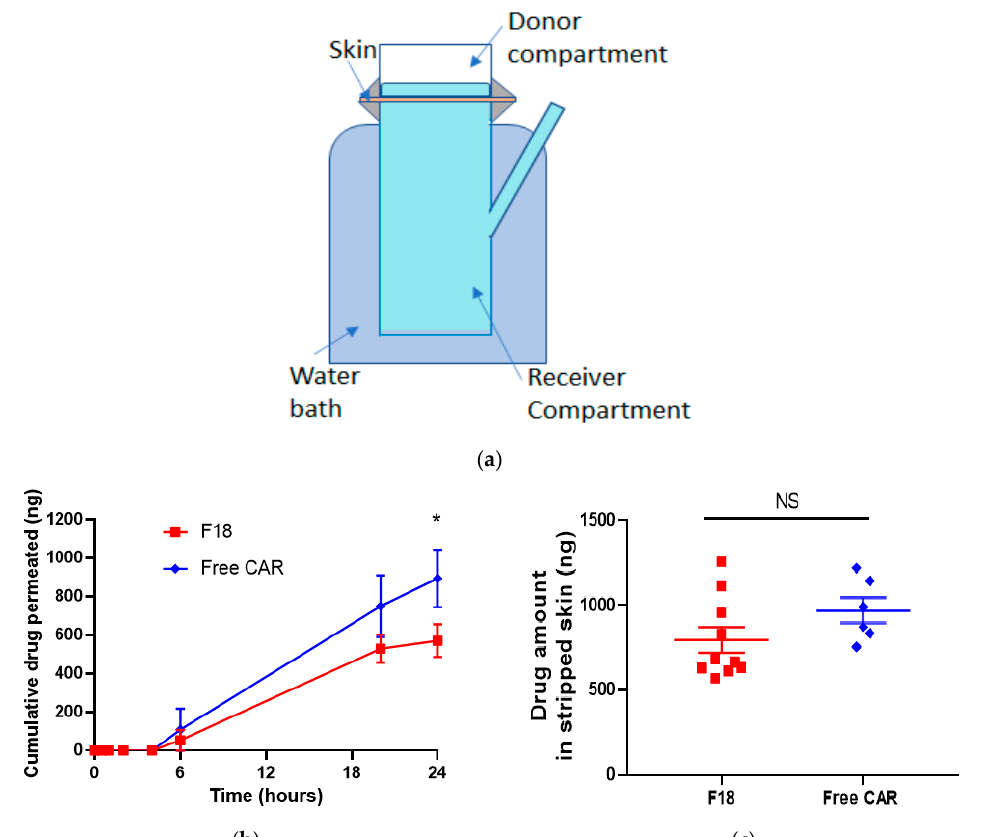
Figure 3. Ex vivo skin drug permeation profiles of free carvedilol and F18. ( a ) Carvedilol acetone solution or F18 (each containing 4.0 μ g carvedilol, 0.2 mL) was added to the donor compartment of a Franz diffusion device. 0.2 mL release media (PBS) was withdrawn at predesigned time points for HPLC analysis. ( b ) Cumulative carvedilol permeated into the receptor compartment as a function of time. ( c ) Carvedilol levels in stripped skin (epidermal and dermal layers). After 24 h, the porcine skin was stripped. Drug levels in stripped skin (epidermis and dermis) was determined via HPLC. Data are presented as mean ± SE. ( n = 10 for F18; n = 6 for free drug). * p < 0.05 student t-test.